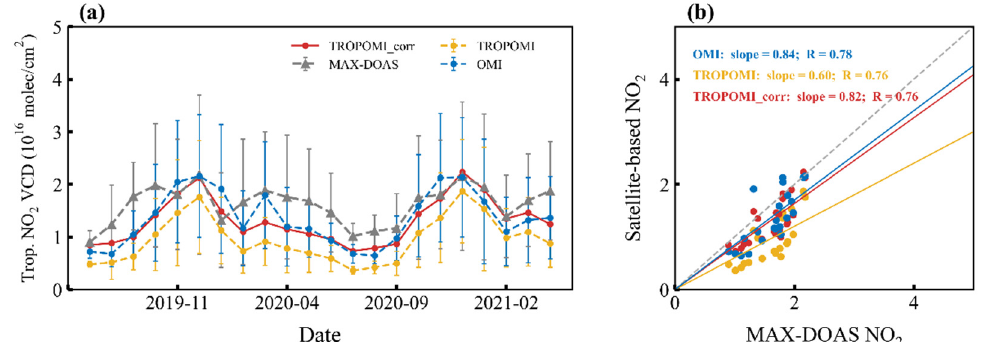
Figure 3. ( a ) Monthly averages of tropospheric NO 2 VCDs based on TROPOMI, OMI, MAX-DOAS and corrected TROPOMI spanning from July 2019 to April 2021. The error bars correspond to the standard deviation. ( b ) Scatter diagram showing the collocated monthly mean satellited-based and GB NO 2 . The 1:1 line is drawn as a dashed line. Blue, yellow and red lines are OMI, TROPOMI and corrected TROPOMI, respectively (units: 10 16 molec cm − 2 ).